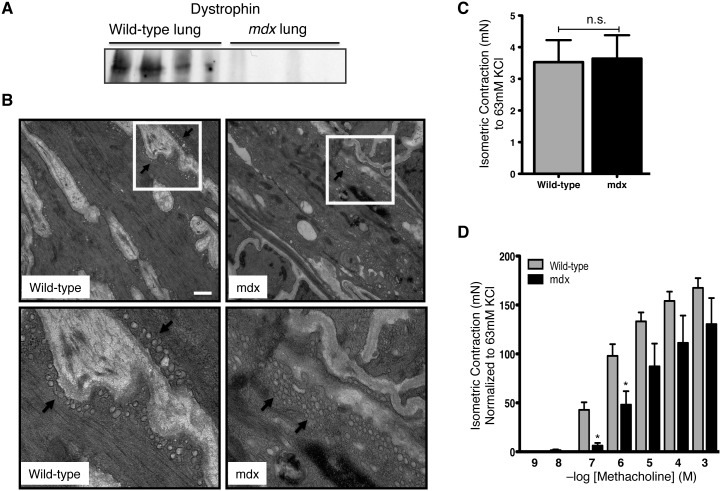
Loss of dystrophin reduces tracheal contractility.
A: representative western blots typical of those obtained for 4 different mdx mice lungs (aged 8–12 weeks) showing dystrophin protein is absent in mdx mice. B: Tracheal tissues from wild type or mdx mice were isolated and then fixed for transmission electron microscopy. Arrows in upper and lower left panels (wild-type) indicate typical caveolae; whereas in upper and lower right panels, arrows indicate internalized caveolae like double-membrane structures that appear more in mdx mice as seen in the lower right panel. Scale bar: 100 nm. Tracheal rings from at least 4–6 mice were used to obtain the above results. Comparing the 2 groups, unpaired t-test indicated a p-value of 0.9136; n.s.
C: tracheal rings from mdx and wild-type mice were isolated and equilibrated for 90–120 min with intermittent (∼20 min) instillation of 63 mM KCl-substituted K-H to obtain a resting tension at ∼0.6 mN. Concentration response studies with methacholine demonstrated significantly reduced responsiveness of mdx preparations at lower concentrations compared to wild-type (D). Statistical comparisons shown were performed by 1-way ANOVA with Tukey’s multiple comparison tests. *P<0.05, for mdx versus wild-type.